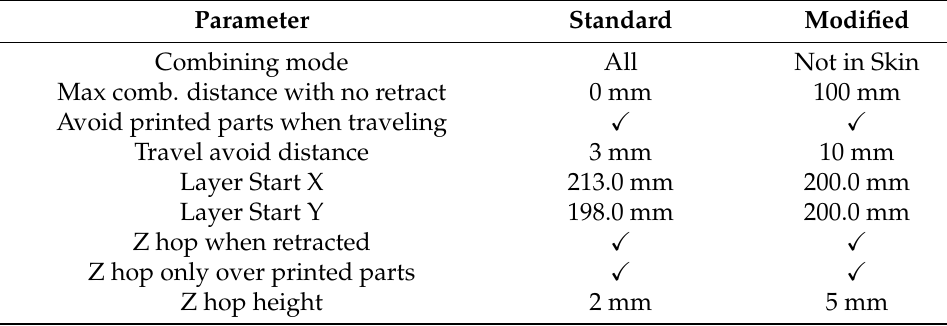
Table 4. Standard and modified travel configurations in